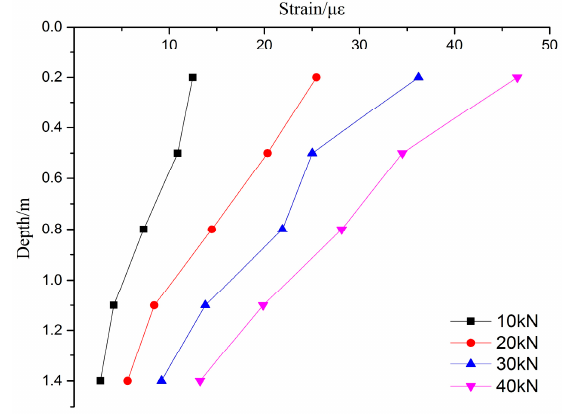
Figure 4. Strain curve of outer wall for the PCC model pile.